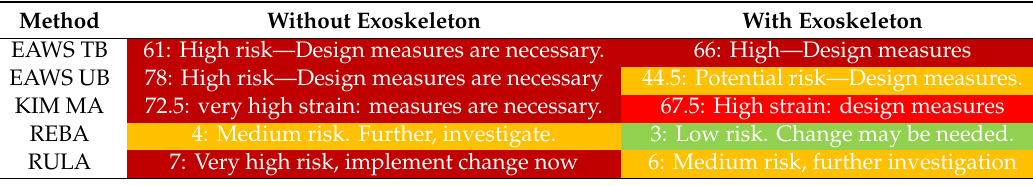
Table 1. Results for di ff erent assessments sheets (EAWS = Ergonomic Assessment Work Sheet, TB = total body, UP = upper body, KIM = key indicator method, REBA = Rapid Entire Body Assessment, RULA = Rapid Upper Limb Assessment)